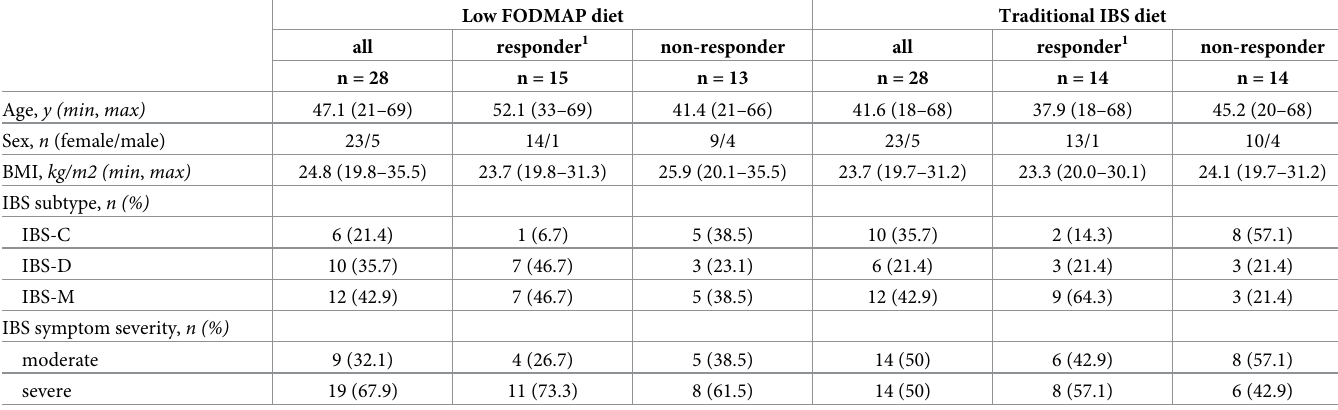
Table 1. Clinical characteristics and demographics of study participants with complete data from pre- and post-intervention.